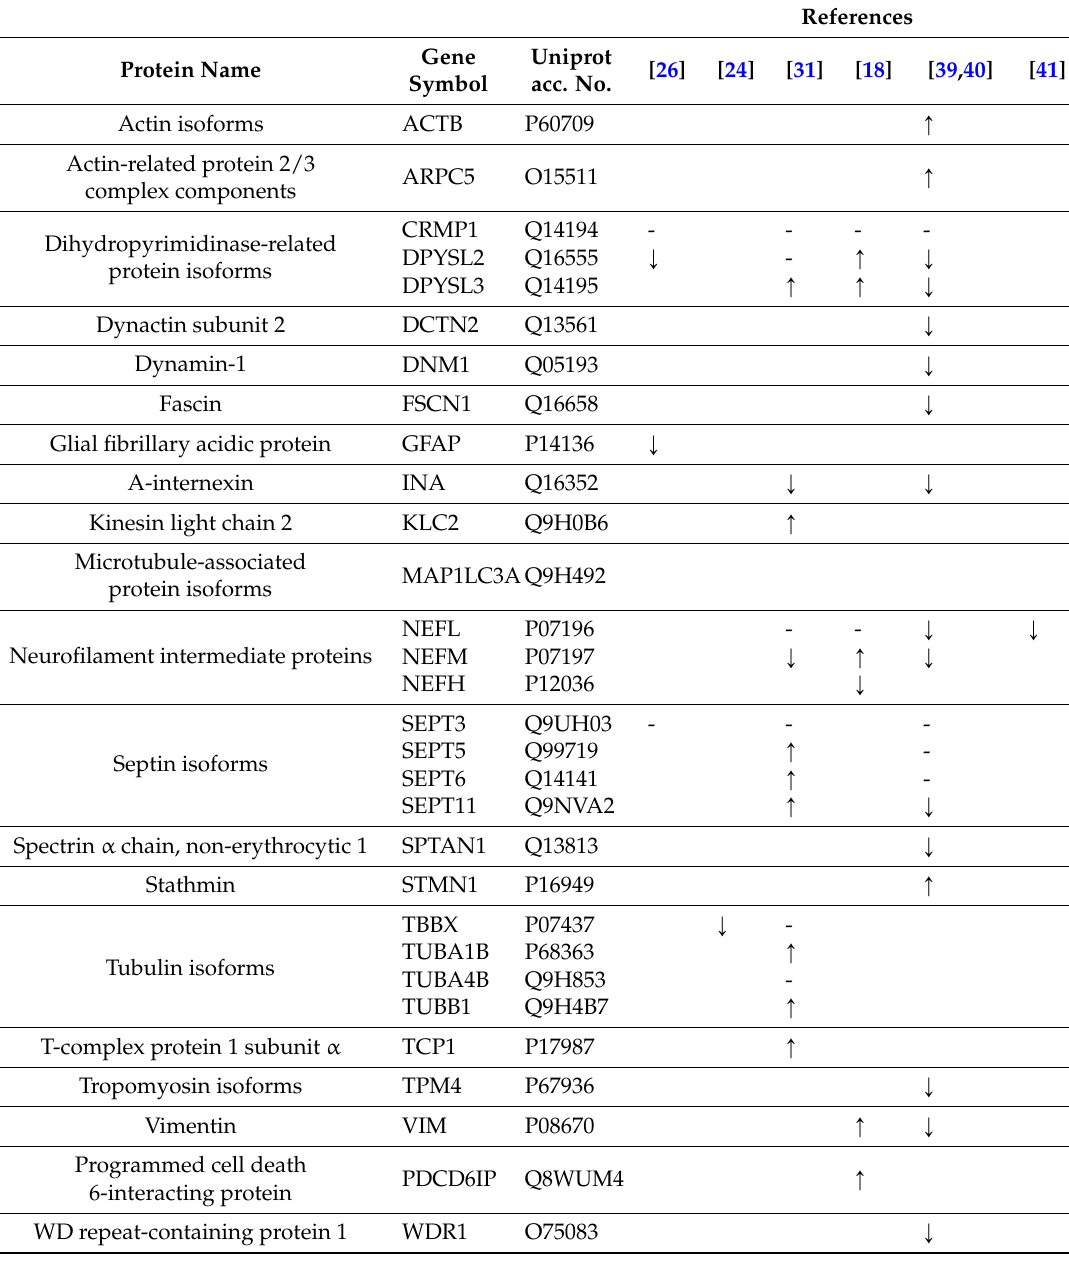
Table 3. Summary of the proteins altered expression from postmortem proteomic investigations of bipolar disorder. Downregulated ( Ó ), upregulated ( Ò